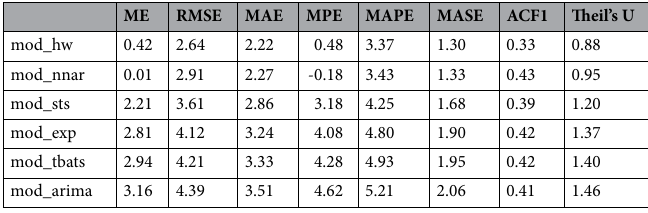
Table 1. Accuracy measures for the six